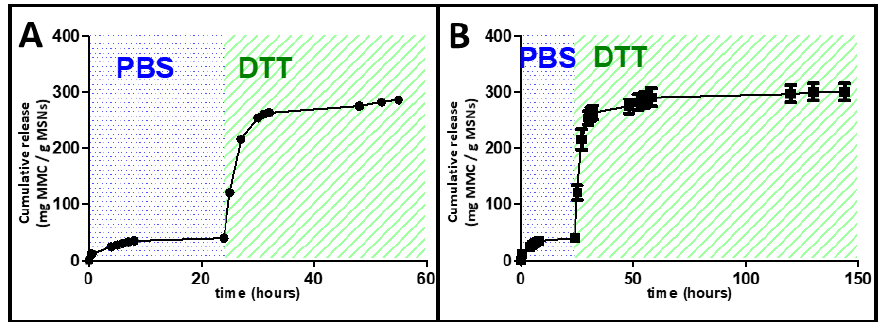
Figure 5. Kinetics of MMC release by DTT; MSNPs-PEG 40 loaded with MLP were incubated with PBS at 37 °C for 24 h. Then, the release medium was changed to DTT 0.5 mM, and MCC release was obtained after 55 h of experiment ( A ) and 150 h of experiment ( B ).